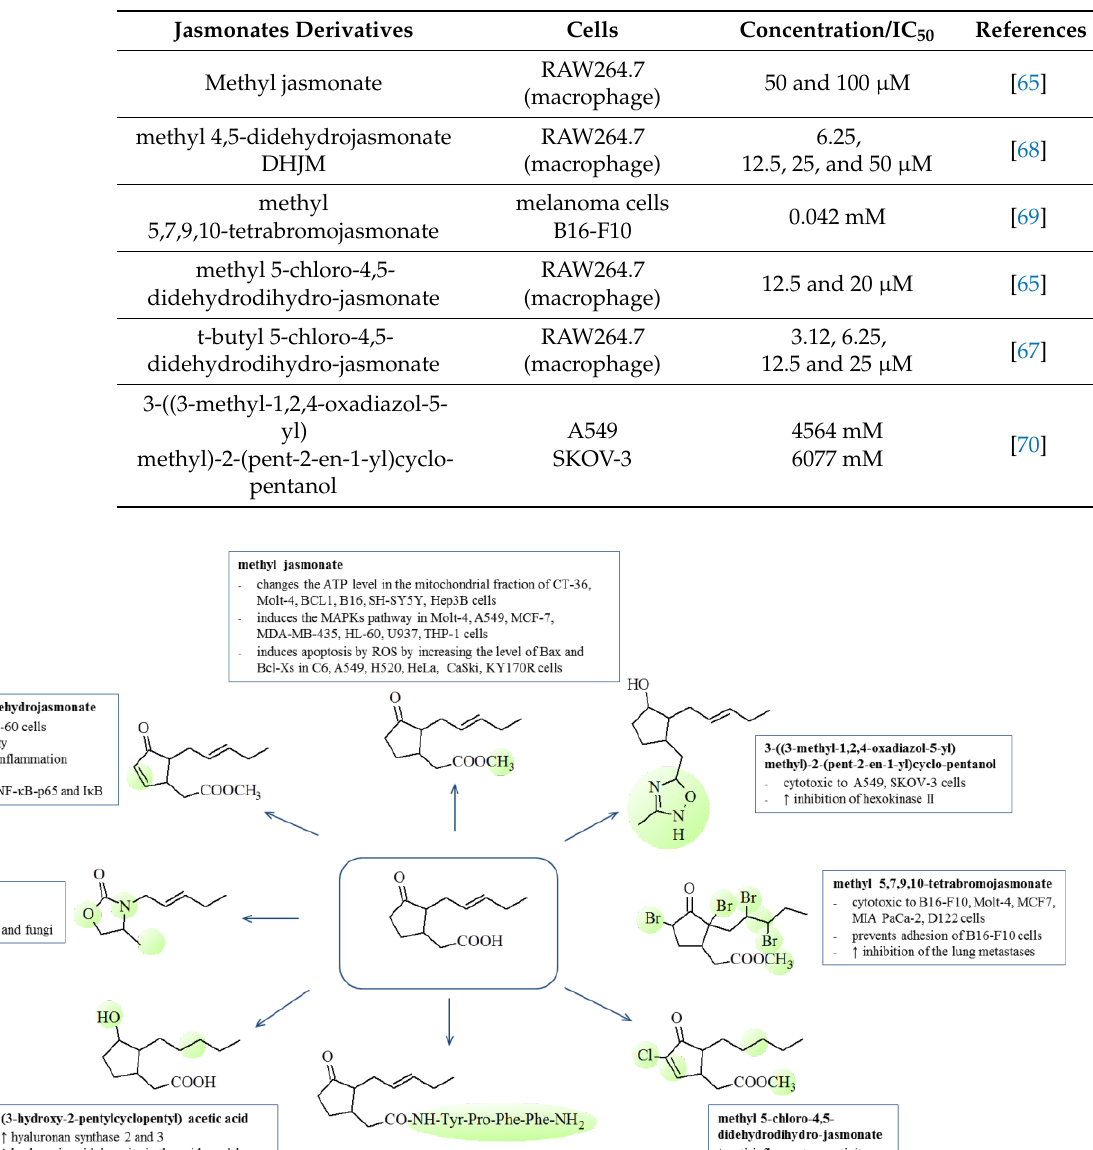
Table 2. New jasmonate derivatives with anti-inflammatory activity.